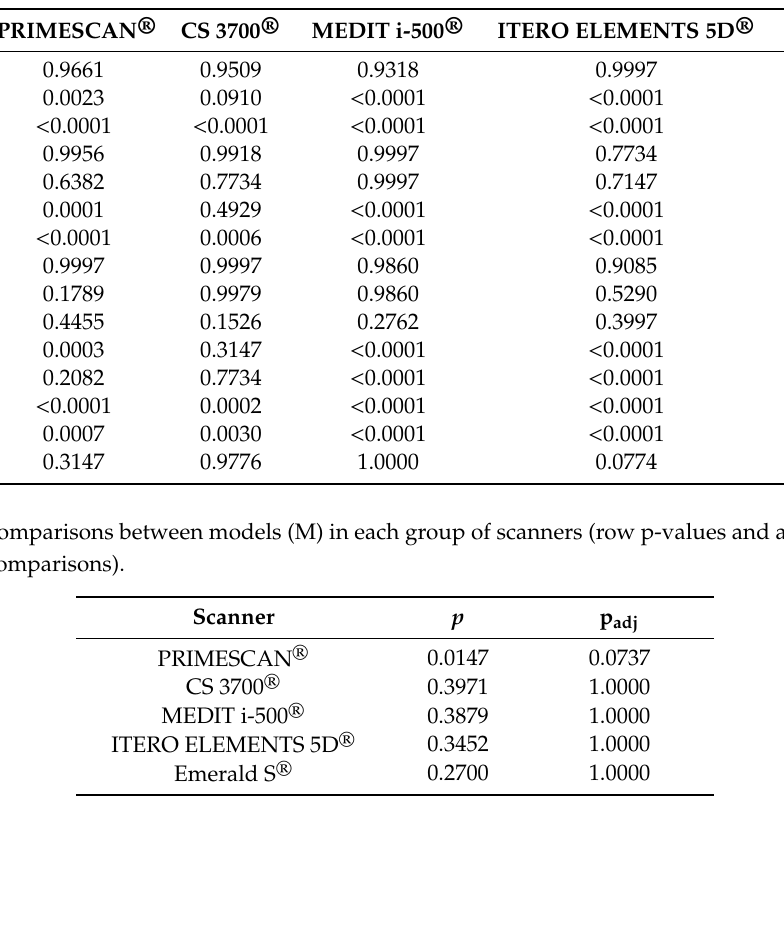
Table 5. Comparisons of mean absolute deviations between SBs in each group of scanners ( p -values).